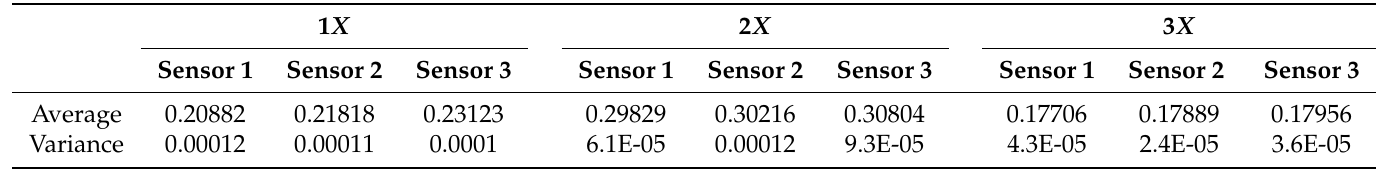
Table 7. The mean values and variances of the measurements under the test mode